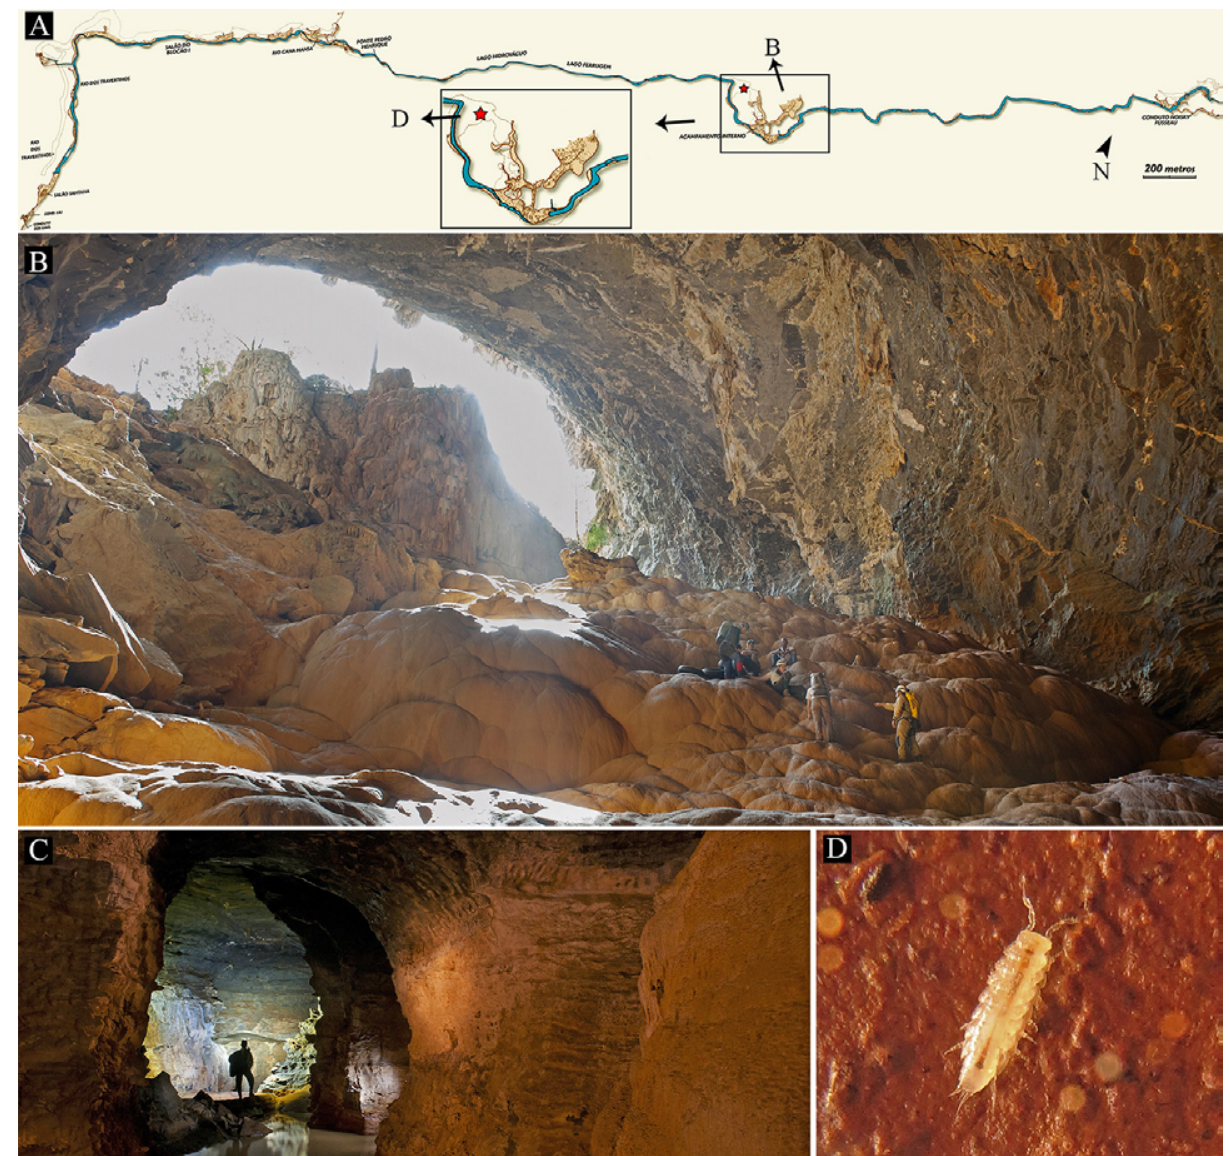
Figure 16. Pectenoniscus santanensis n. sp. A , Gruta do Padre cave map, the dotted line represents the upper level, with collecting site; B , entrance of Gruta do Padre cave, inside the cave; C , main conduit of Gruta do Padre cave; D , specimen of Pectenoniscus santanensis n. sp., approximately 2